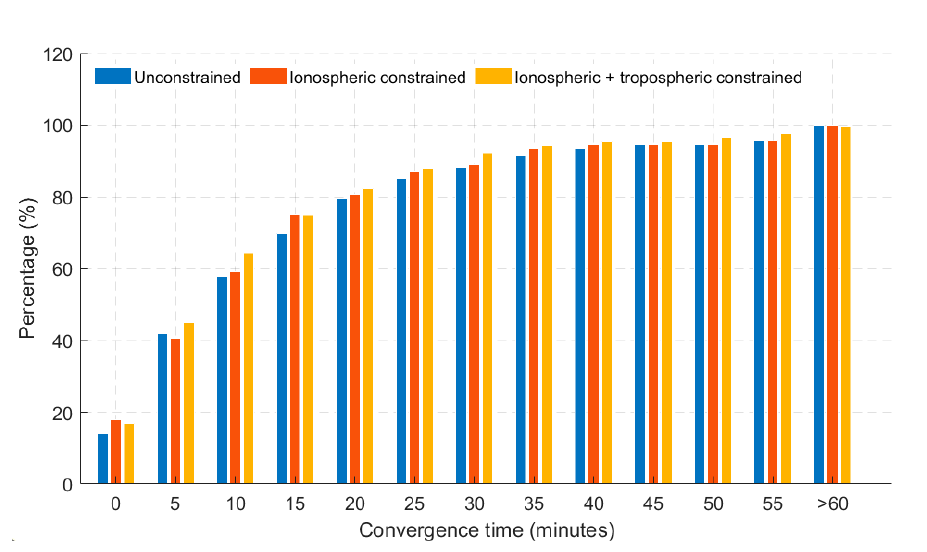
Figure 11. 95th percentile time series showing horizontal positional error (hourly) based on 24 hourly solutions for 40 stations for dual-frequency GREC with GPS-AR processing mode. Blue dotted line represents the 10 cm convergence threshold.